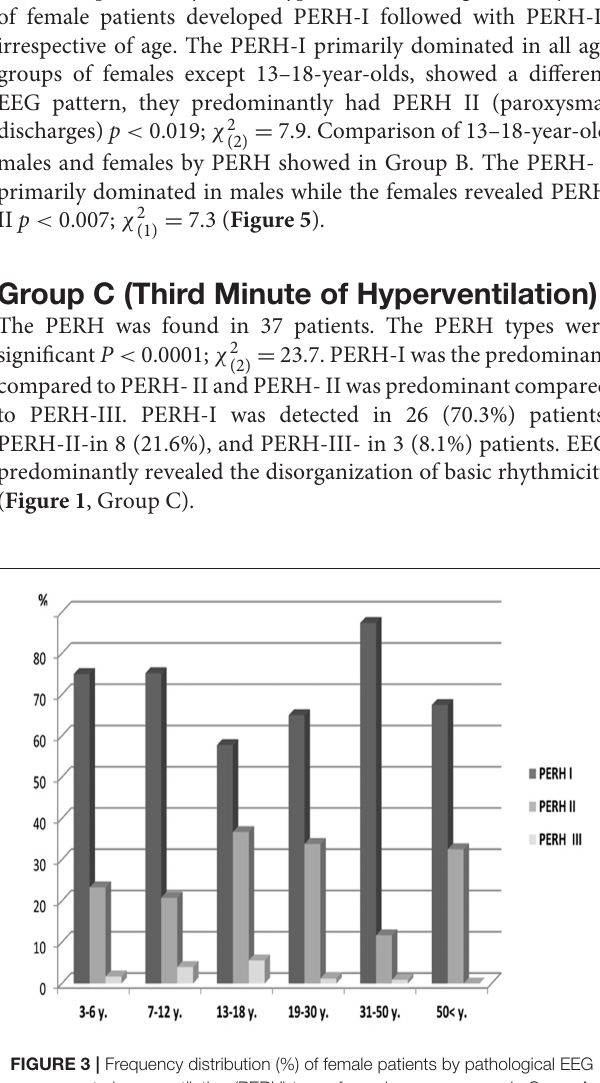
FIGURE 3 | Frequency distribution (%) of female patients by pathological EEG responses to hyperventilation (PERH) types for various age groups in Group A. A majority of female patients developed PERH-I followed with PERH-II ( p < 0.05) irrespective of age.